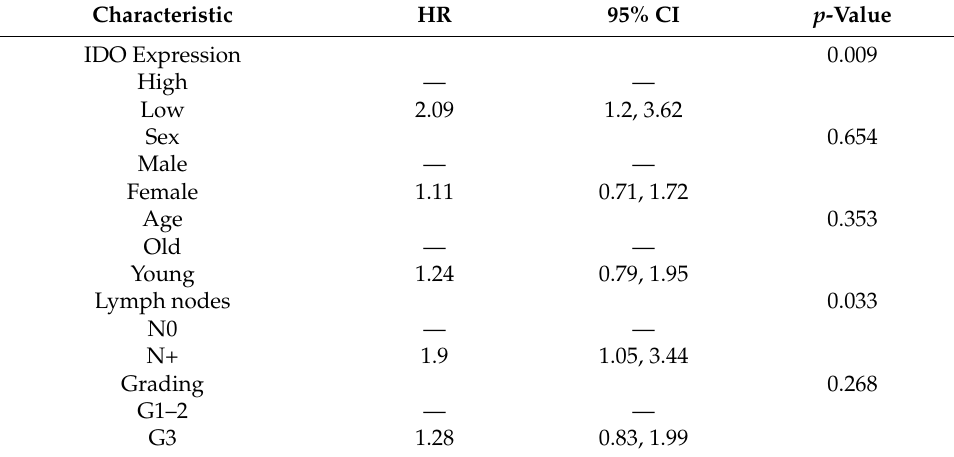
Table 5. Multivariate Cox proportional hazard regression analysis for IDO expression and clinico- pathological factors. IDO expression and lymph node status are independent predictors for survival. HR 95% CI